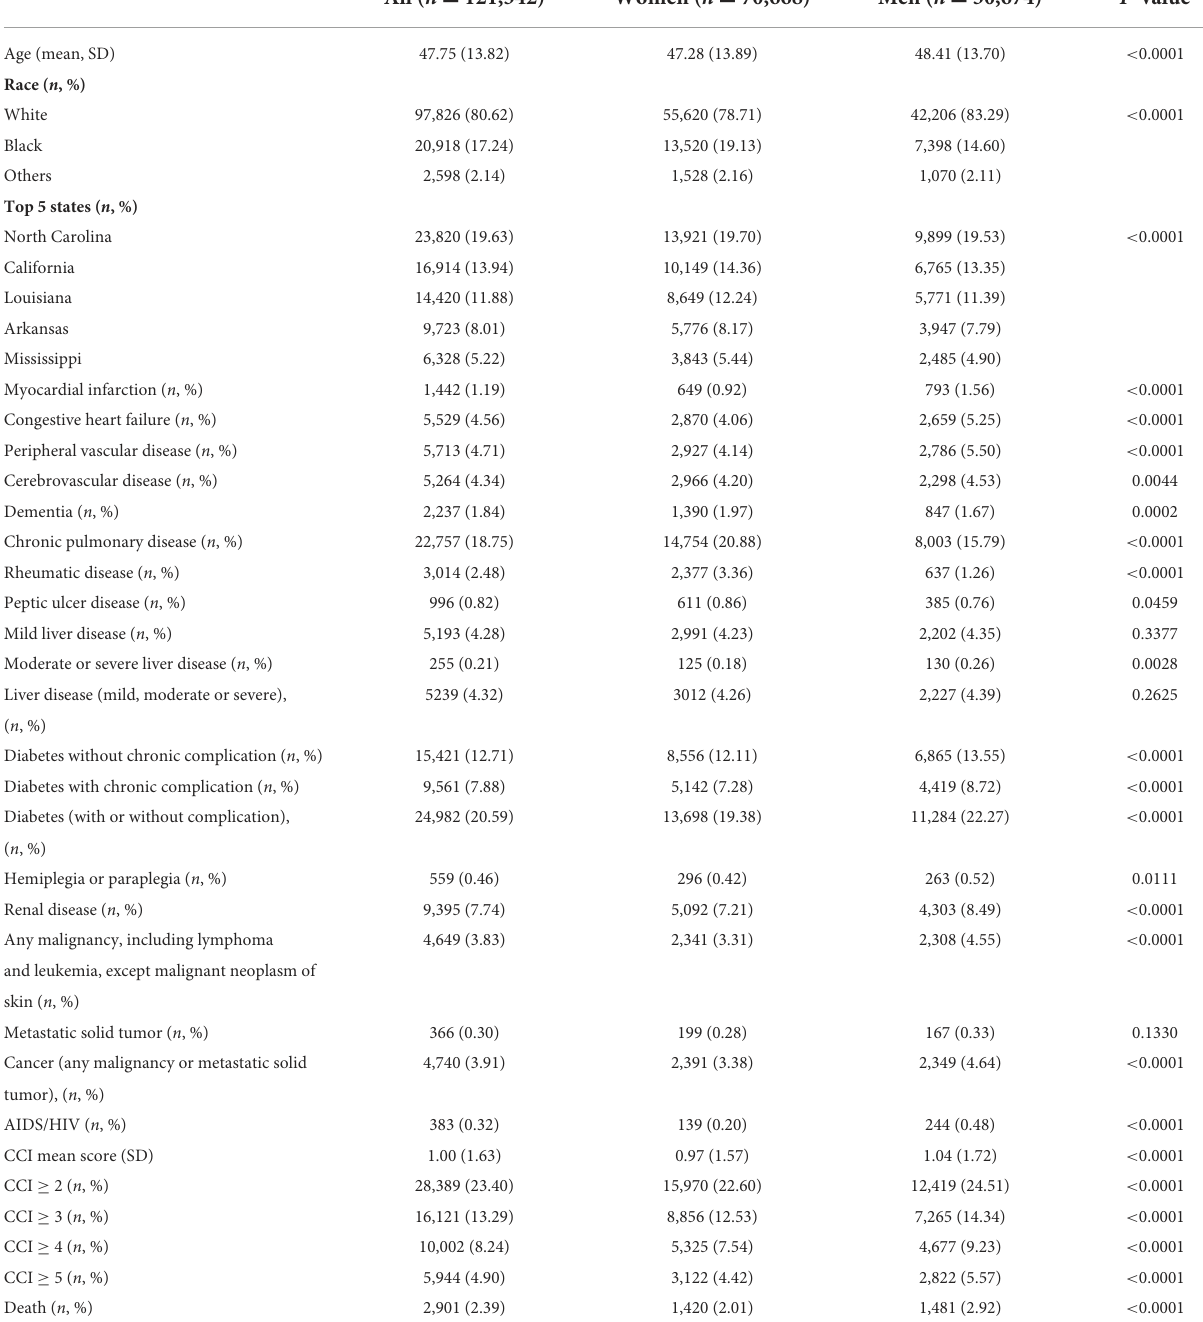
TABLE 1 Characteristics of COVID-19 patients by